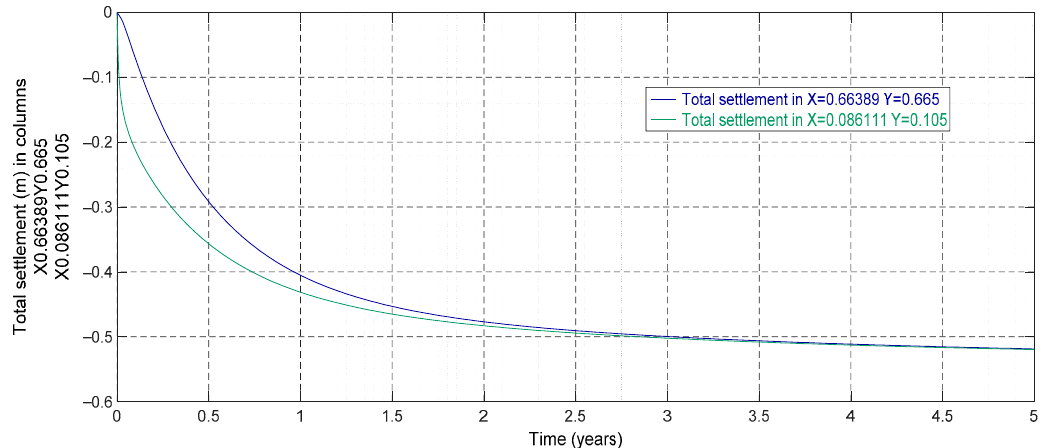
Figure 19. Surface settlement evolution in two soil columns. (a = b = 0.7 m; c = 0.05 m; d = 4 m).